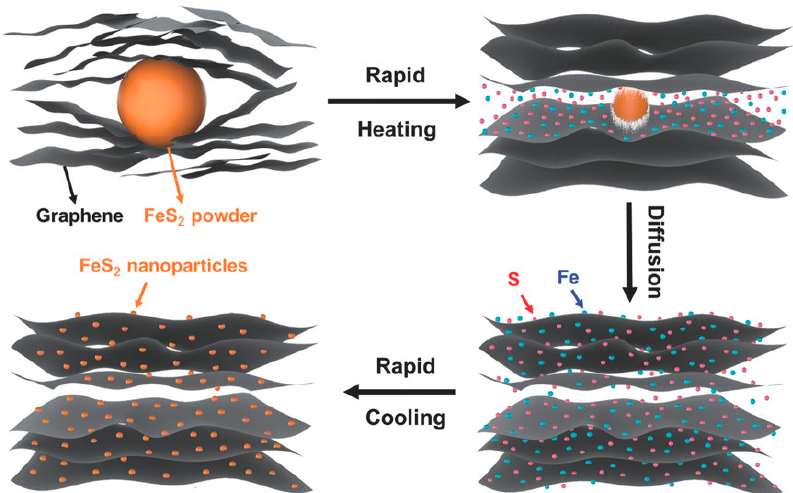
Figure 5. Ultrafast transformation of microscopic FeS 2 mineral into FeS 2 nanoparticles: A thermal shock (2470 K, 12 ms) initiates the decomposition of FeS 2 into Fe and S atoms. Subsequent recrystallization of Fe and S atoms at rGO defects delivers nano-FeS 2 -rGO. Reprinted with permission from reference [69]